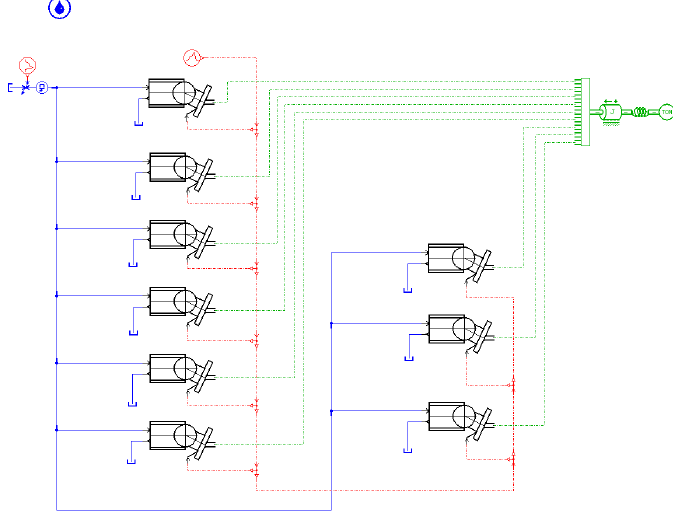
Figure 13. Simulation model of an axial piston pump with 9 pistons.